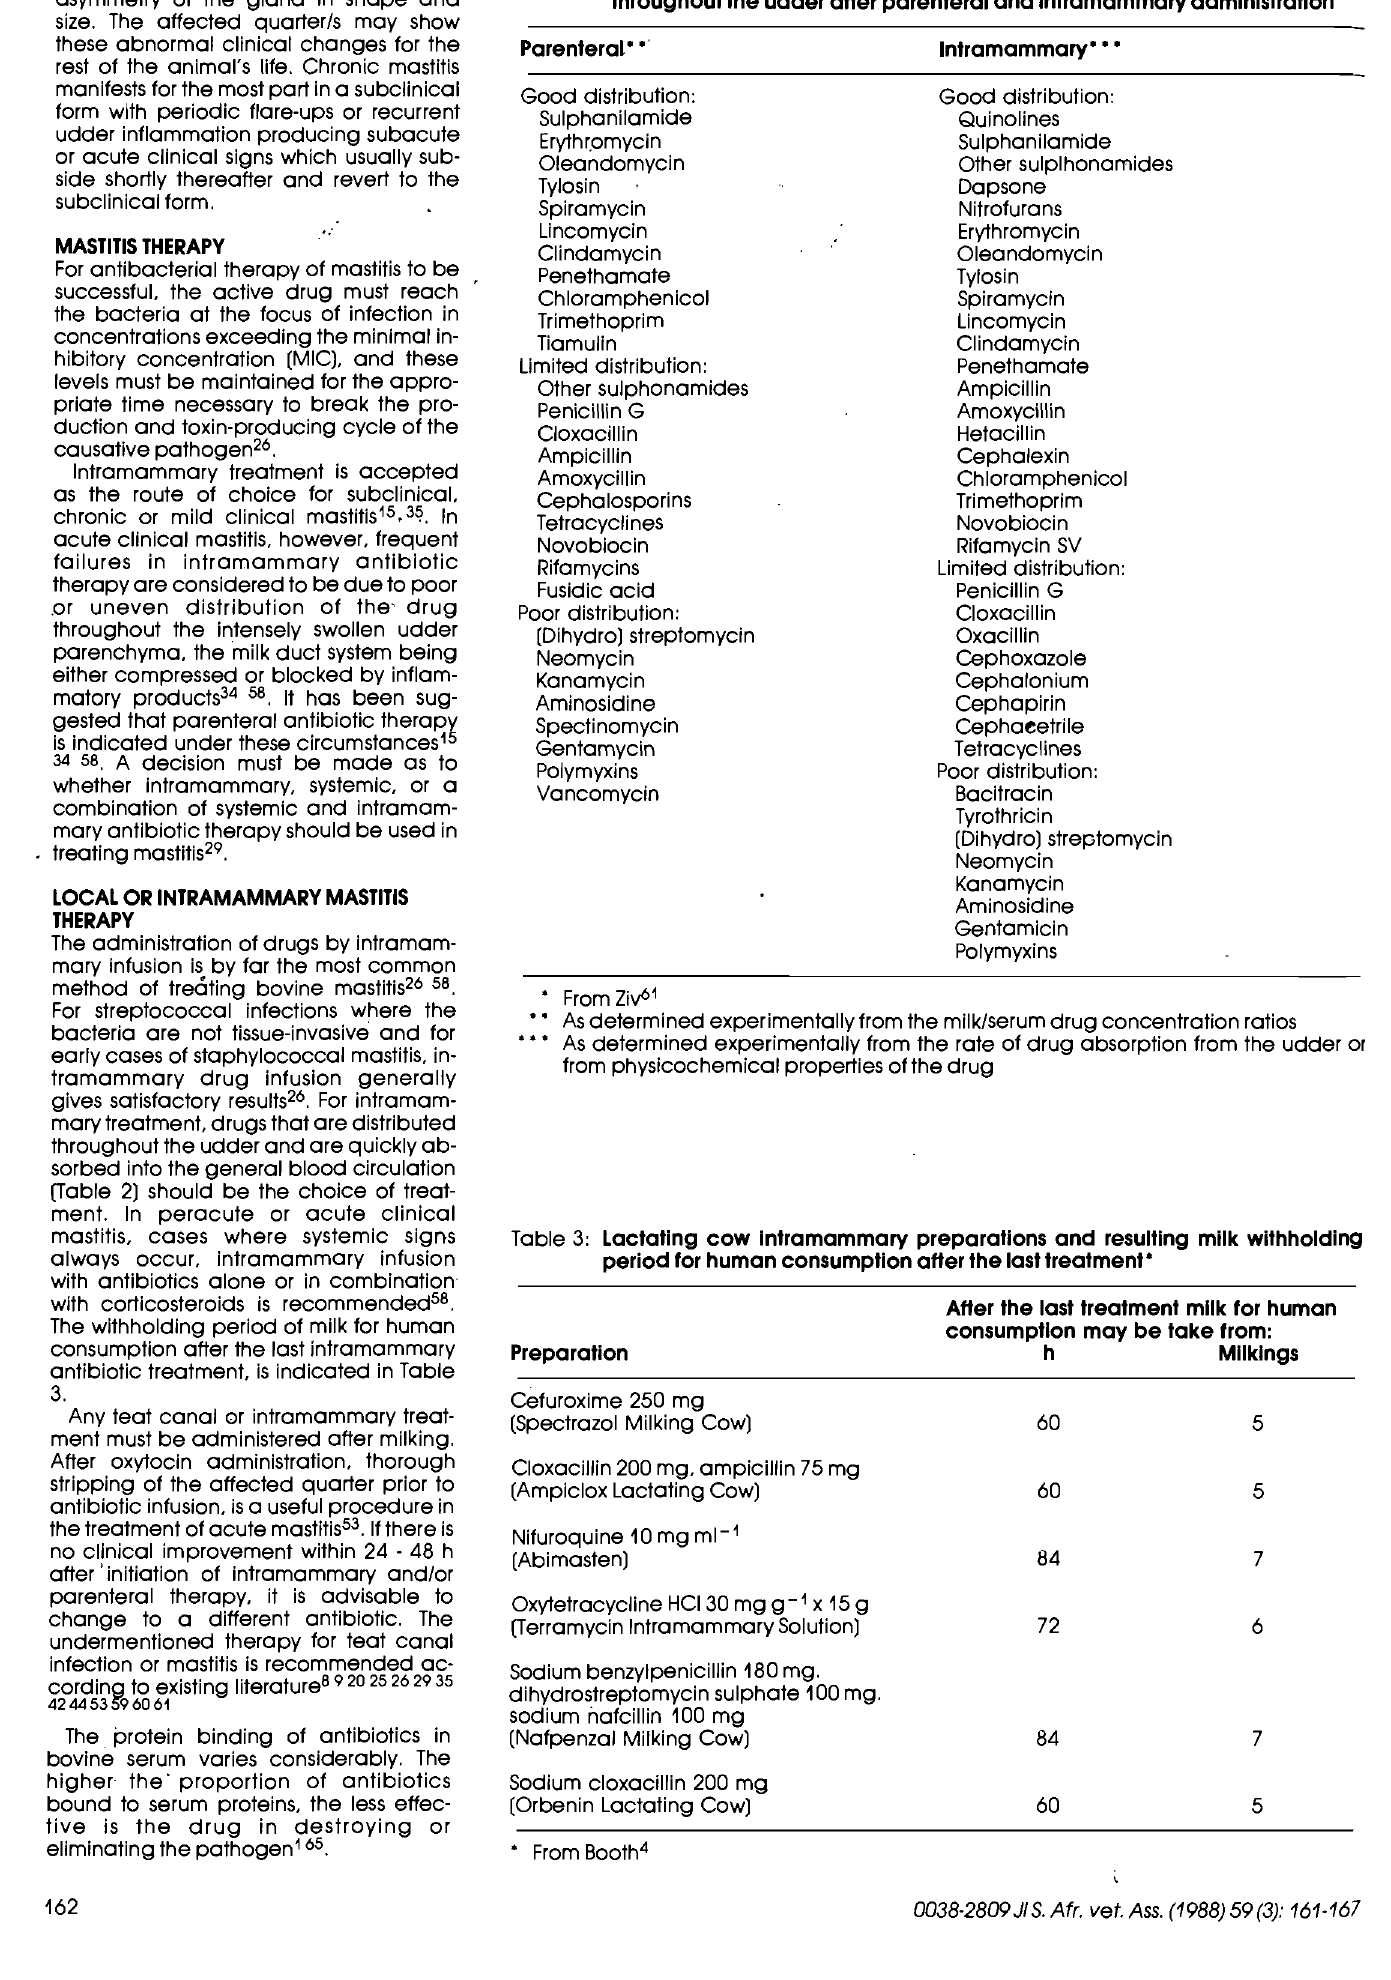
Table 2: Classification of antibacterial drugs according to their potential distributior throughout the udder aHer parenteral and intramammary administration· Parenteral· •.